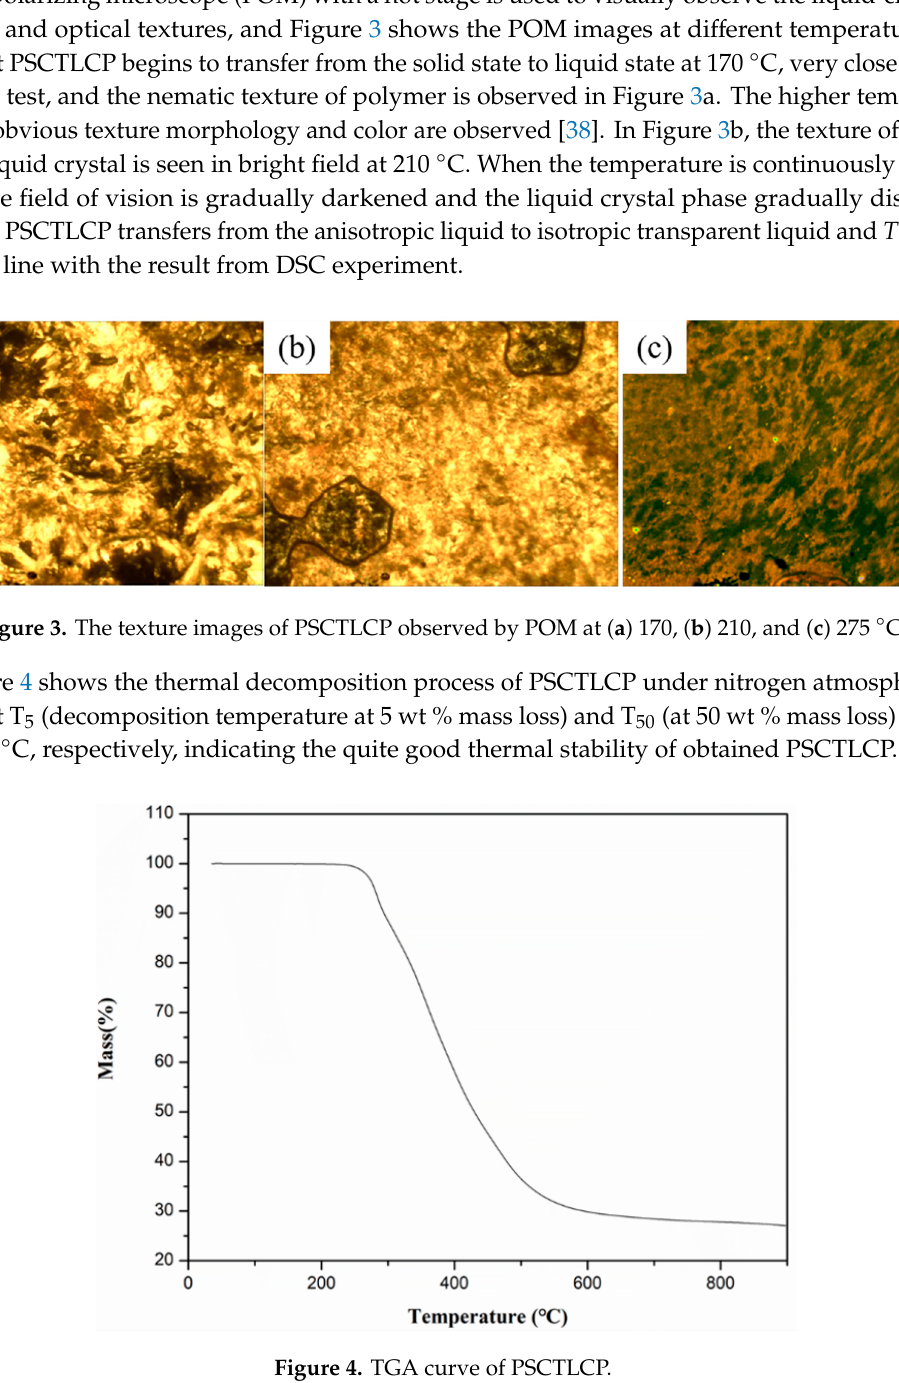
Table 2. DSC data of PSCTLCP in nitrogen atmosphere.